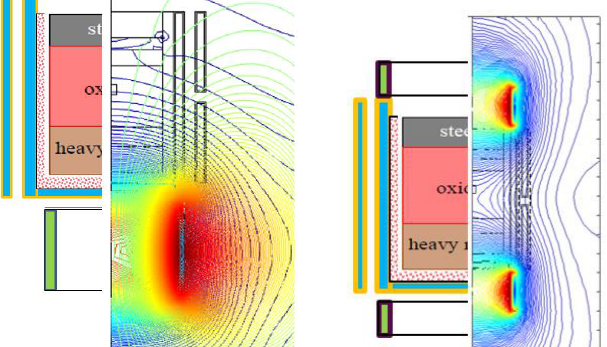
Fig. 7. Example of tested configurations of exciting coils arrangement (located only at the bottom and both at bottom and top)